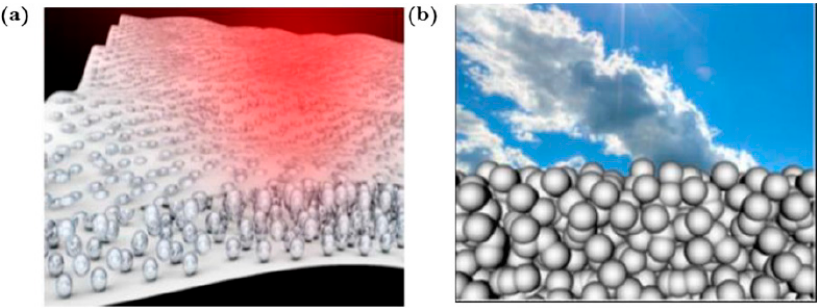
Figure 21. ( a ) Random NP-based designs for radiative cooling using SiO 2 microparticles and ( b ) Photonic random media based on SiO 2 microspheres [38,69].